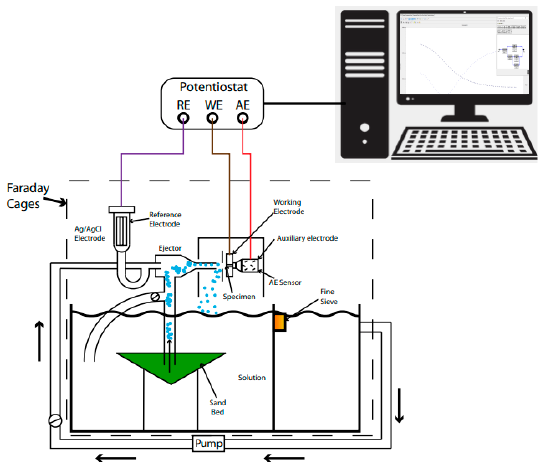
Figure 1. Schematic of the equipment used in the corro-erosive wear test. AE: auxiliary electrode; WE: working electrode; RE: reference electrode.